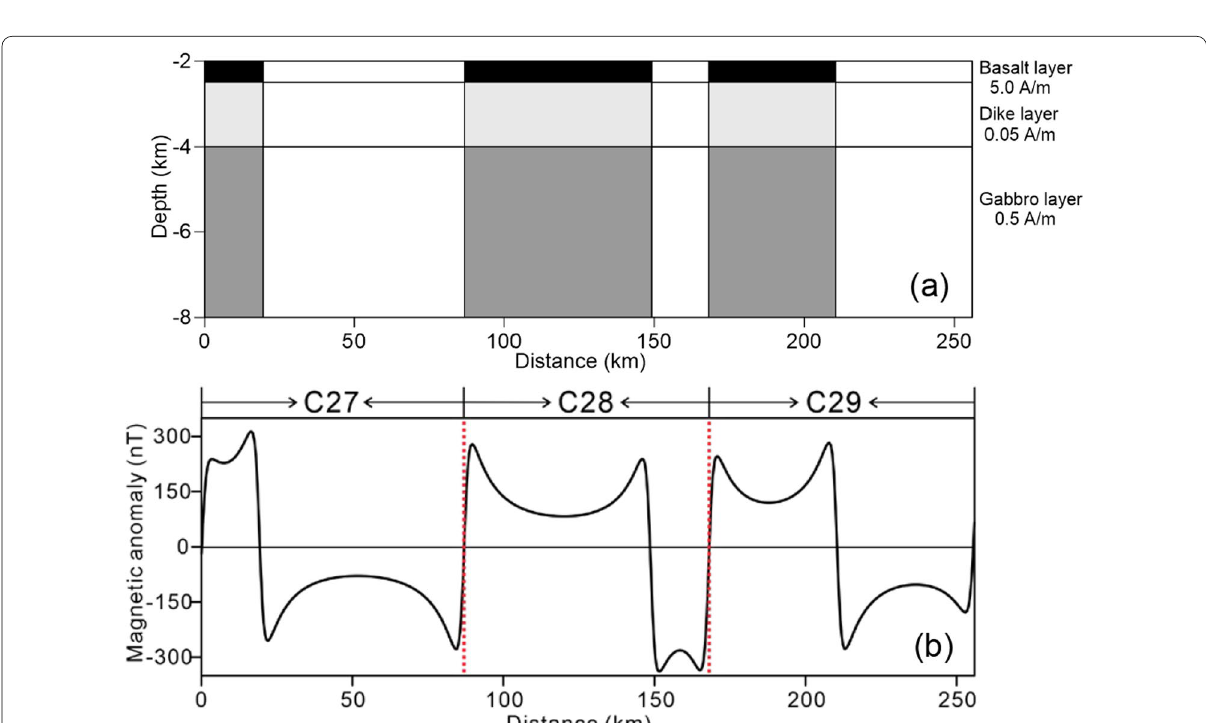
Fig. 3 The three-layer oceanic crust model and forward modelled marine magnetic anomalies. a Schematic diagram of the three-layer oceanic crust model. b The forward modelled marine magnetic anomalies of the three-layer oceanic crust model. Red dashed lines show the boundaries for different polarity chrons from C27 to